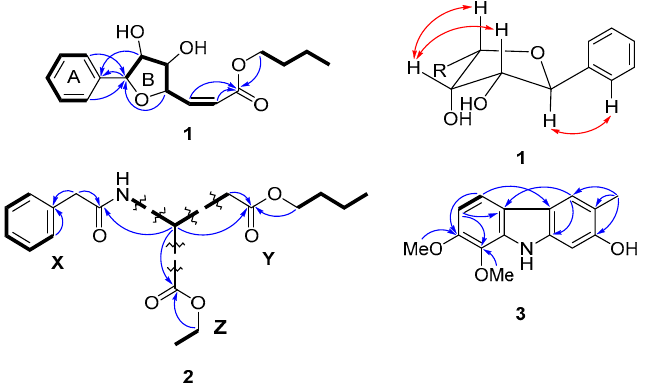
Figure 2. Key COSY (bold), HMBC (arrow), and NOESY (double arrow) correlations of 1 ‒ 3 . Table 1. 1 H NMR (600 MHz) and 13 C NMR (150 MHz) spectroscopic data of 1 in CDCl 3 .